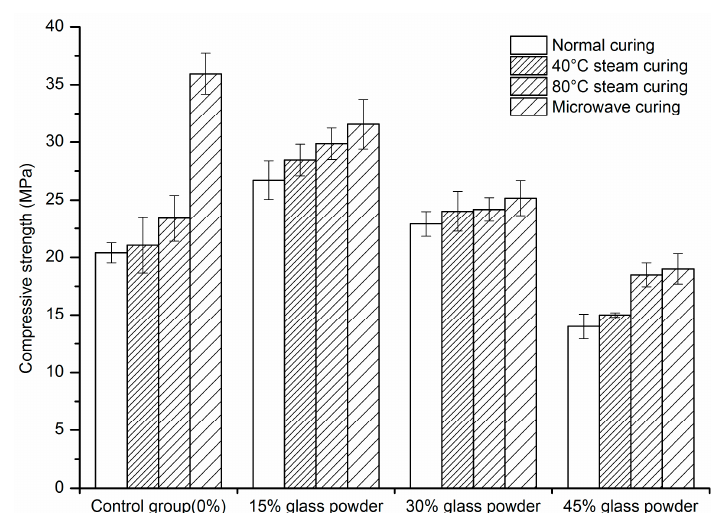
Figure 2. The compressive strength of mortar at 28 days.